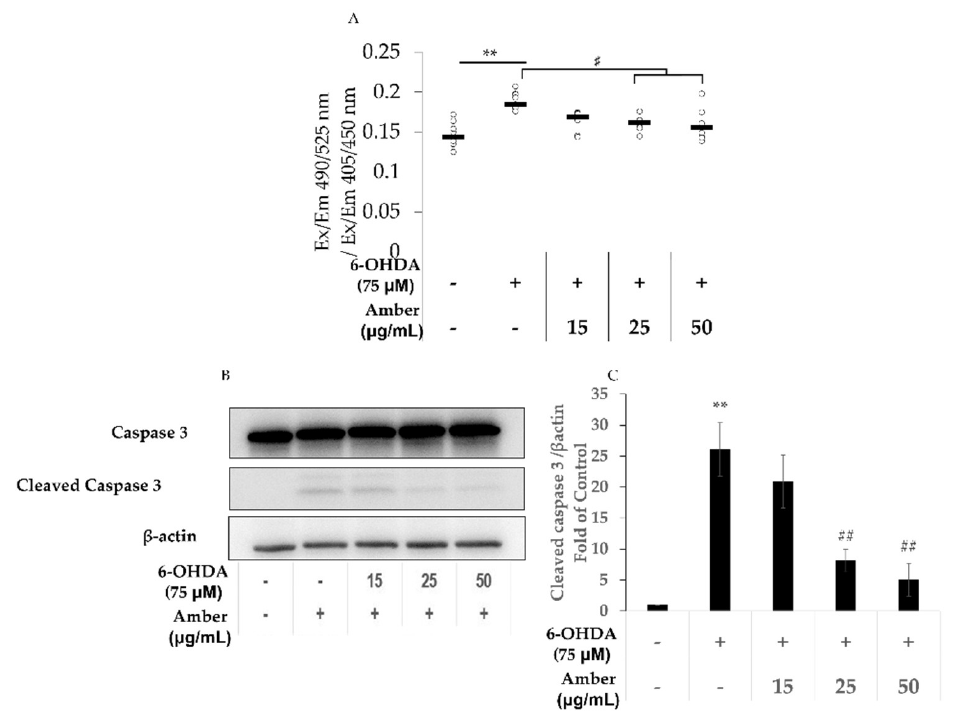
Figure 2. Effect of amber extract on 6-hydroxydopamine (6-OHDA)-induced cell apoptosis: SH-SY5Y cells were cultured in DMEM/F12 medium with 10% FBS. After 24 h of seeding, the cells were pretreated with amber extract for 24 h, and then the medium was replaced with fresh 6OHDA-containing medium for another 6 h for apoptosis assay, and 24 h for WB. Control (Ct): (6-OHDA/amber) −/−, 6-OHDA: (6-OHDA/amber) +/−, Amber: (6-OHDA/amber) (+/15 μg/mL; +/25 μg/mL, +/50 μg/mL). ( A ) Apoptosis analyzed using a fluorescence microplate reader. ( B ) Representative Western blot image of caspase-3 and cleaved caspase-3. ( C ) The protein bands of cleaved caspase-3 were quantified using ImageJ. The results are expressed as the mean ± standard deviation. n ≥ 3, ** p < 0.01 vs. Control, # p < 0.05 vs. 6-OHDA, ## p < 0.01 vs. 6-OHDA.